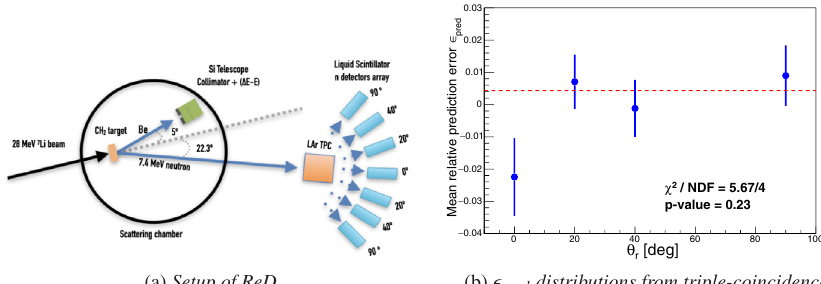
Figure 1: (a) Schema of the experimental setup of the ReD experiment. (b) Mean relative prediction error for each (cid:31) pred distribution obtained by splitting data into the four angular datasets. The red dashed line marks the (cid:31) pred = 0.0043 level (no directional e ff ect). value is on average lower for those events with traces parallel to the direction of the drift field. From the definition in (1), this should stand for a predicted S2 value greater than the experimentally measured one. This shows that the derived model tends to overestimate S2 for events with traces parallel to . Such a result is expected in the case of directionality e ff E d